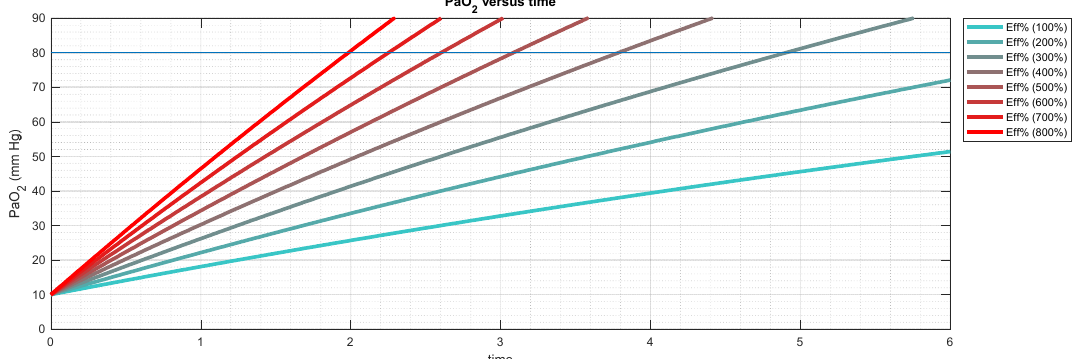
Figure 1. A graphical illustration of the diffusion of oxygen at different efficacy levels compared to untreated patients. The diffusion ratio or maximum rate of diffusion is 800% at F i O 2 = 1 and 200% at F i O 2 = 0.3 when compared to breathing room air without treatment. This efficacy refers to the rate at which oxygen is transferred from the alveolus to the venous blood in the pulmonary artery at the initial exposure of the air to the hypoxemic blood across a membrane. The figure illustrates that for higher efficacy, the P a O 2 will reach normoxia sooner or more likely during tidal breathing during treatment.